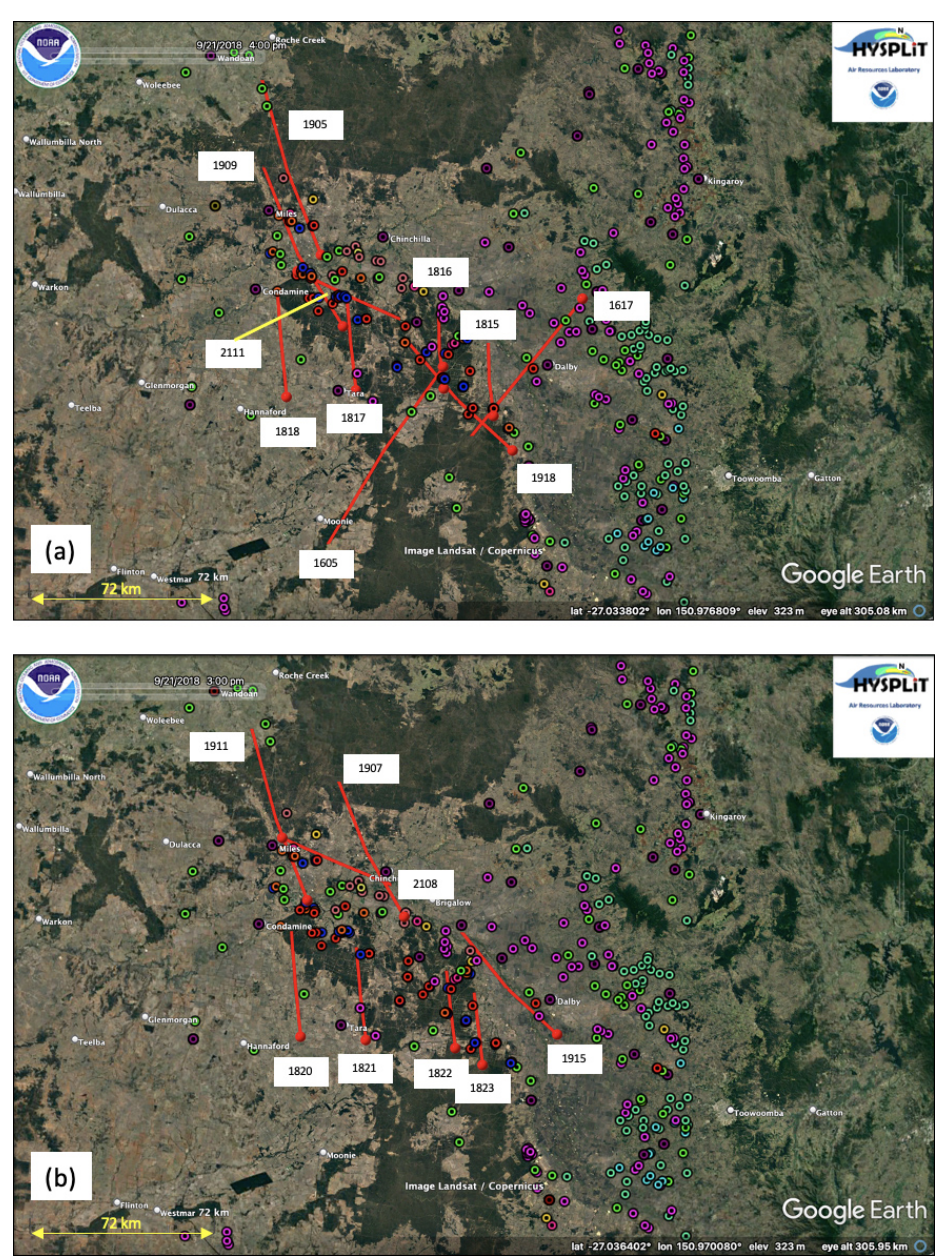
Figure A3. Two-hour HYSPLIT back-trajectory path lines (red) for the points used in the coal seam gas Keeling-model regression anal- ysis. (a) HYSPLIT back trajectories CSG > 50% BU inventory, altitude 250–350ma.g.l. (b) HYSPLIT back trajectories CSG > 50% BU inventory, altitude 100–200ma.g.l. Refer to Fig. A1 for the point source colour key (image © Google Earth).